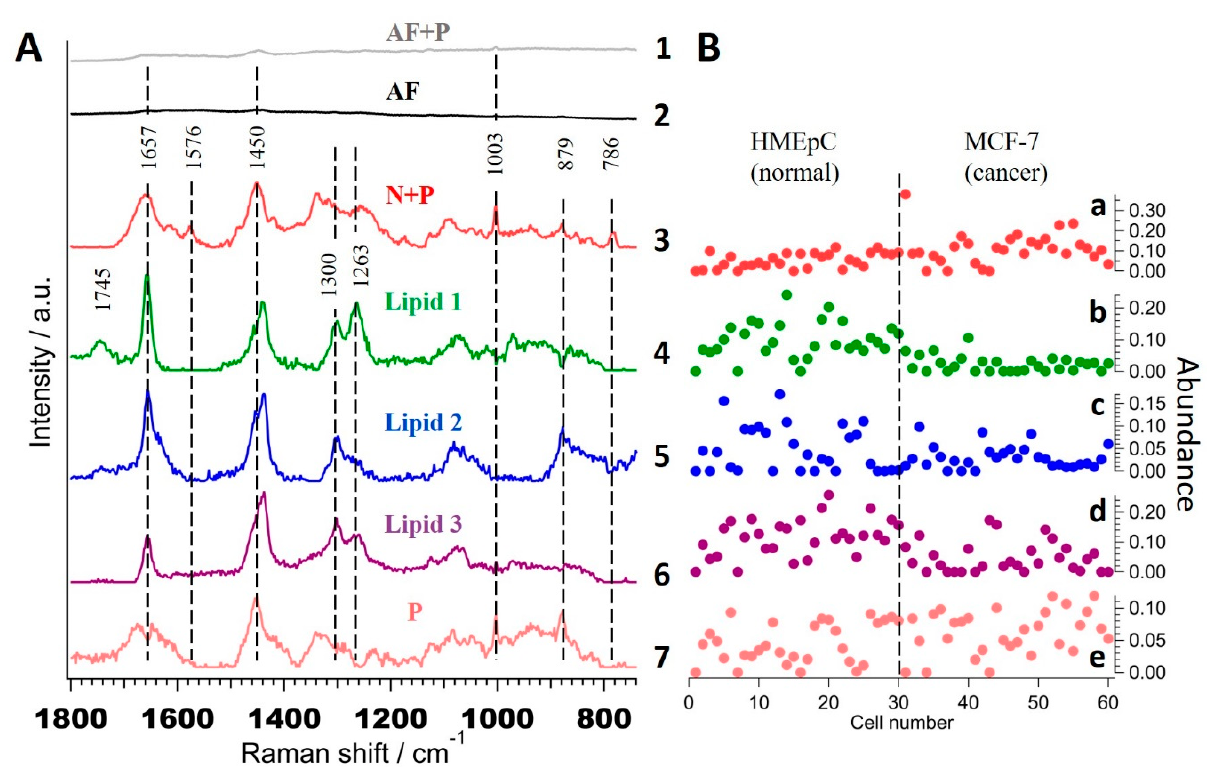
Figure 4. Seven components MCR-ALS analysis. ( A )The extracted spectral components, ( 1 ) autofluorescence with protein [AF + P], ( 2 ) autofluorescence [AF], ( 3 ) nucleic acid with protein [N + P], ( 4 ) Lipid 1, ( 5) Lipid 2, ( 6 ) Lipid 3 and ( 7 ) Protein [P]. ( B ) Abundance profiles of ( a ) N + P, ( b – d ) lipid 1–3 and ( e ) protein, respectively. Broken line in B separates HMEpC and MCF-7 cells.